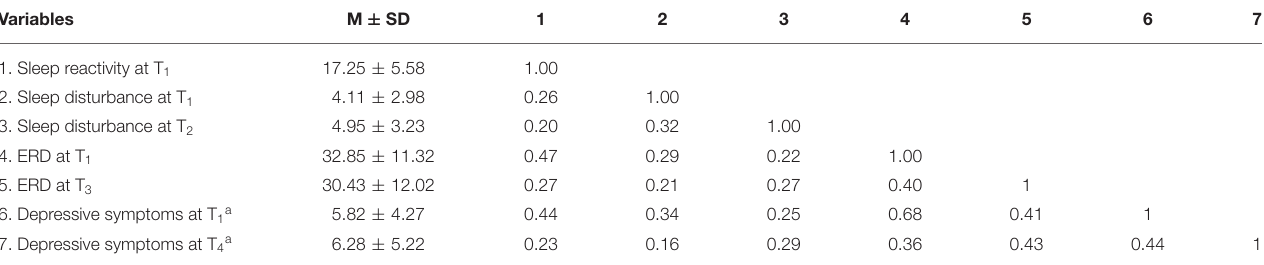
TABLE 2 | Descriptive statistics and correlations for main measures. Variables